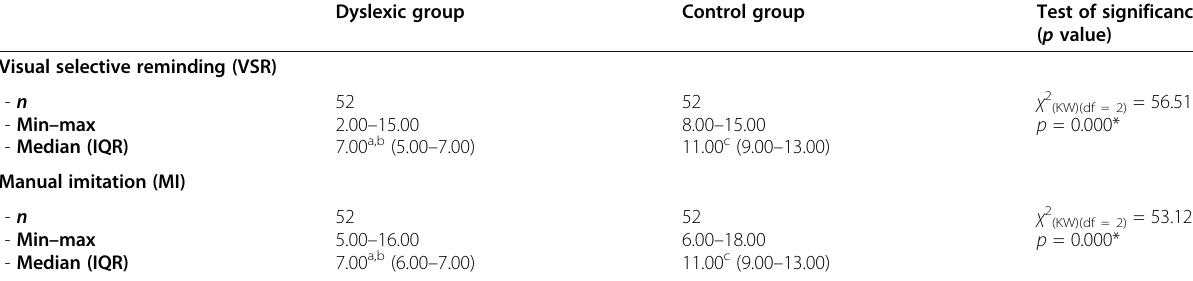
Table 3 Comparison between the studied groups as regards supplementary (non-verbal subsets) Dyslexic group Control group Test of significance